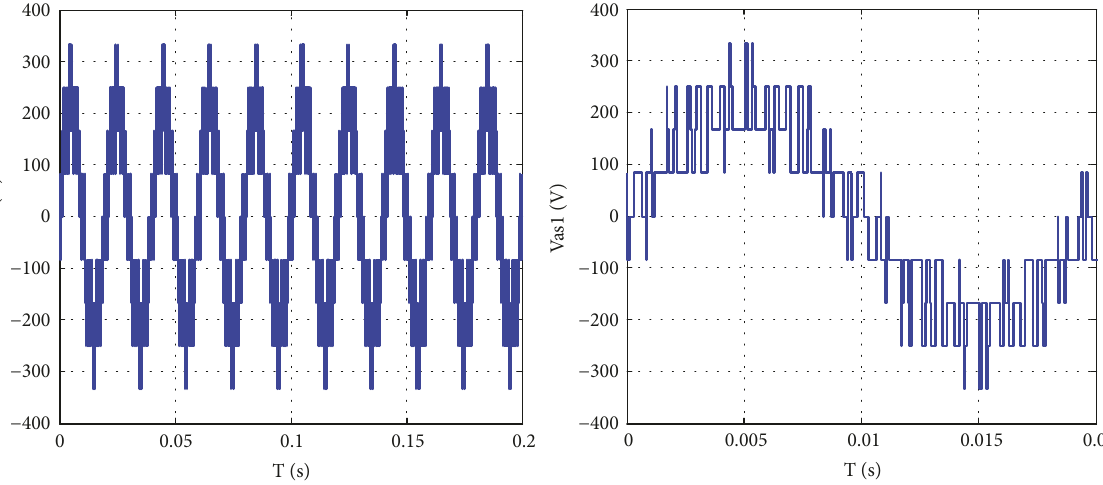
Figure 4: Waveform of output voltage 𝑉 𝑎𝑠1 for m=3.